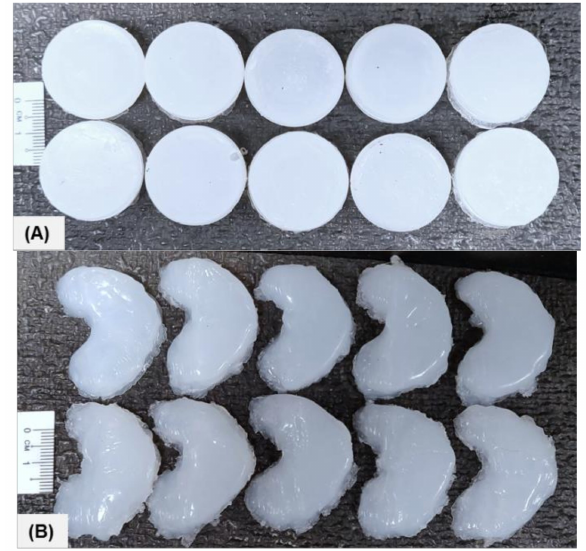
Figure 4. Photograph of the standard and meniscus samples: ( A ) STD-Eco30 samples (top row) and STD-Eco50 samples (bottom row) and ( B ) 3DP-Eco30 samples (top row) and 3DP-Eco50 samples (bottom